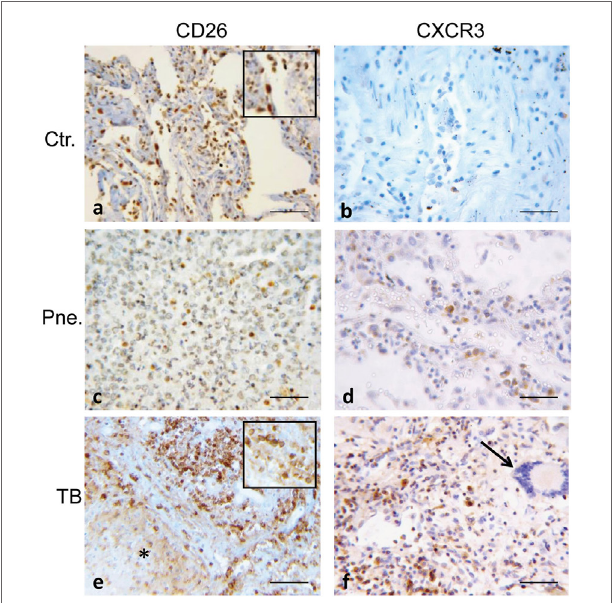
FigUre 5 | Representative images of normal control lung (Ctr), of pneumonia (Pne) and necrotic and inflammatory zones of tuberculosis (TB) are immunostained for CD26 (DPP4) and CXCR3 (CD183). (a) In control lung, many CD26-positive cells are visible, consisting not only in lymphocytes but also in mesenchymal/endothelial cells lining alveolar space (magnified image in the insert shows CD26-positive mesenchymal/ fibroblast cell). (c) In pneumonia, rare positive cells corresponding morphologically to lymphocytes, are shown. (e) Strongly CD26-stained cells are clustered in inflammatory area surrounding necrotic lesion of TB lung; they appear morphologically consistent with lymphocytes (as seen in magnified image in the insert). (F) CXCR3 is strongly expressed in lymphocytes in the inflammatory region of tuberculous lesion; on the right a multinucleated giant cells (arrow) not labeled (B,D) . Rare CXCR3 expressing cells are present both in pneumonia and in controls. Scale bars: (a–F) = 50 μ m.